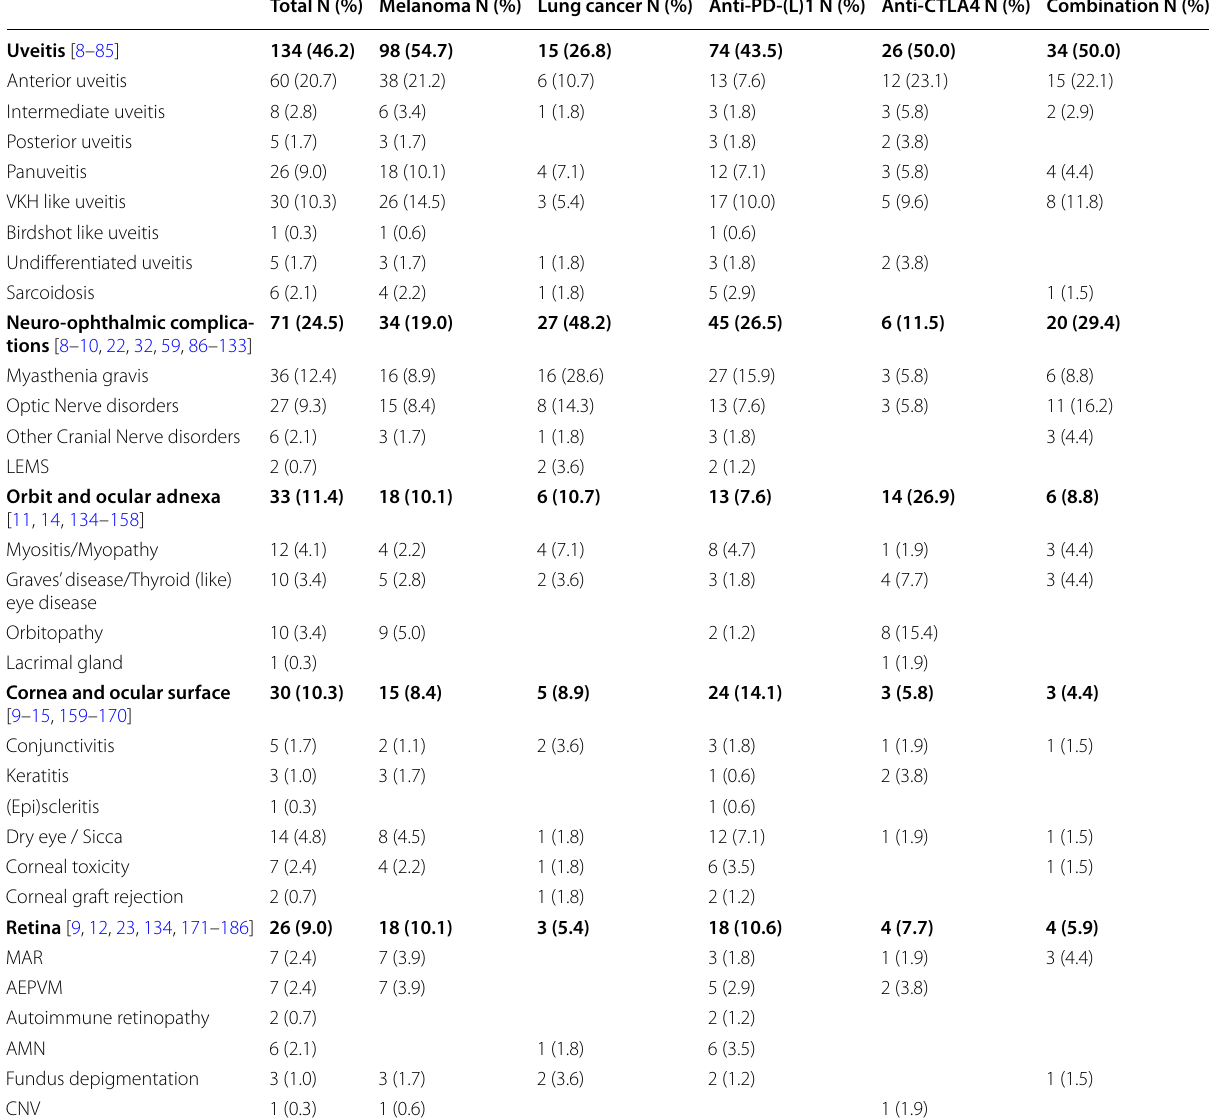
Table 5 Overview of reported ocular side effects related to primary tumor and ICI used